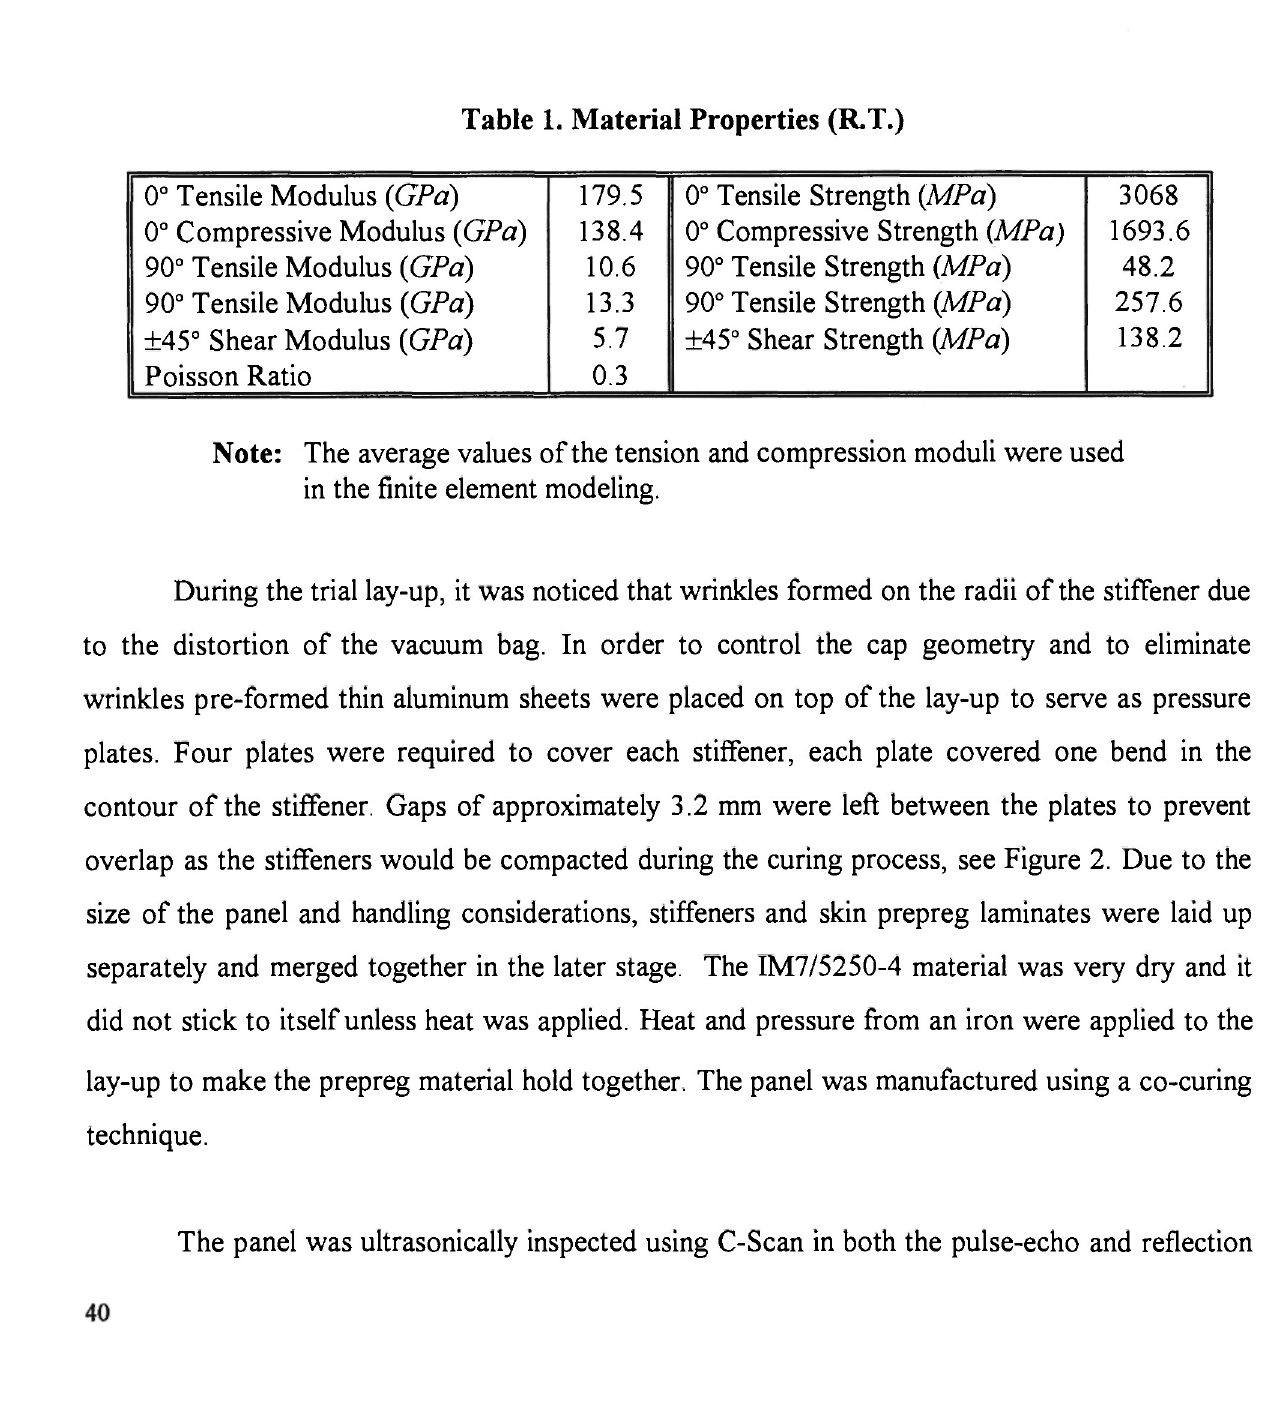
Table 1. Material Properties